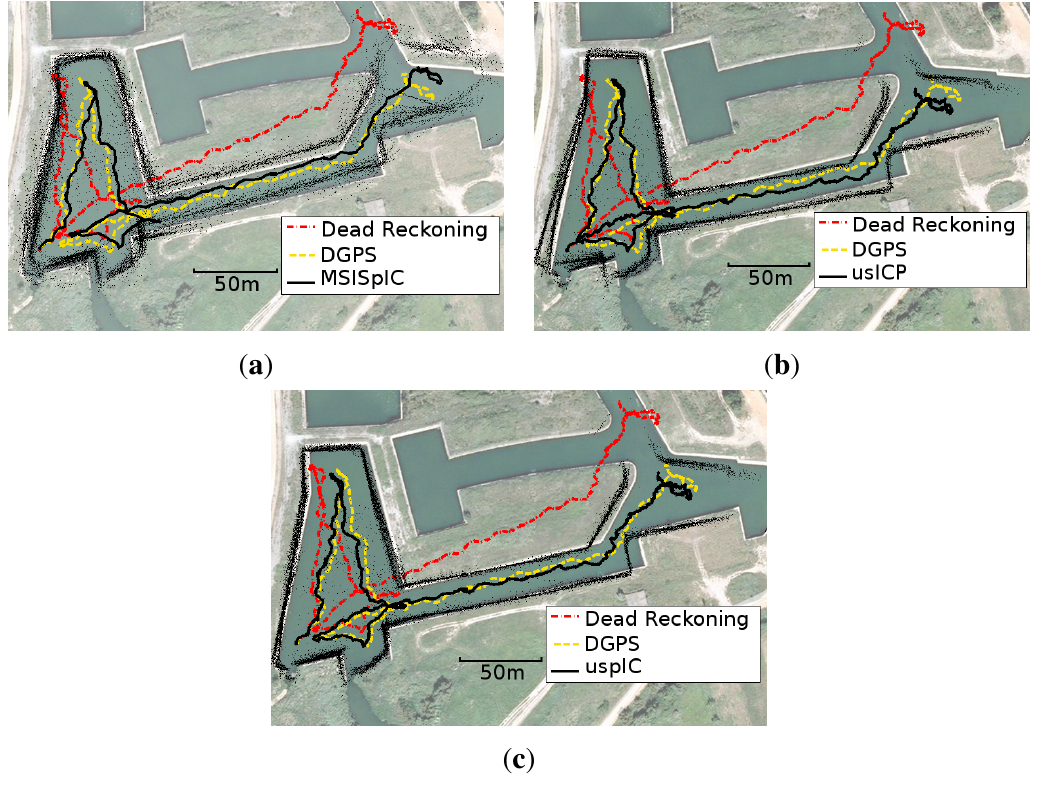
Figure 17. Trajectories corresponding to GPS, dead reckoning and ( a ) MSISpIC; ( b ) usICP; and ( c )